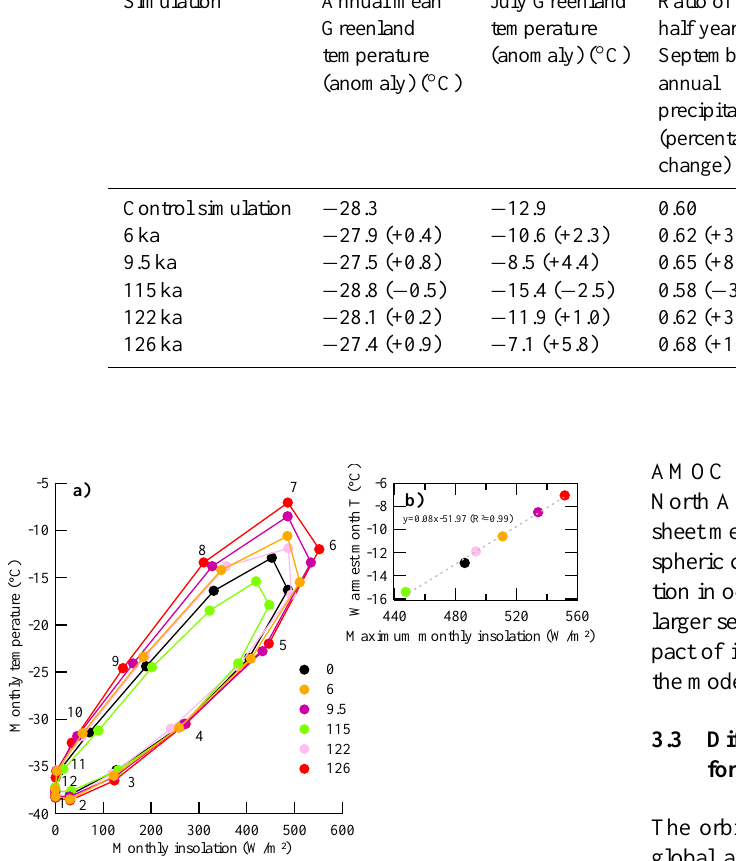
Fig. 2. (a) Seasonal cycle of IPSL model simulated central Green- land ( > 1300m) temperature ( ◦ C) as a function of the seasonal cy- cle of TOA incoming solar radiation at 75 ◦ N (Wm − 2 ) for different orbital configurations (0, 6, 9.5, 115, 122 and 126ka). For each period, the monthly data are displayed; black numbers indicate the number of the month (from 1 for January to 12 for December). The elliptic shape results from the phase lag between temperature and insolation. (b) Regression between maximum monthly insolation and the IPSL model central Greenland maximum monthly summer temperature (occurring one month after maximum insolation). A linear relationship is observed, with a slope of 0.08 ◦ C per Wm − 2 . The same color code is used as in panel a for the various simula-